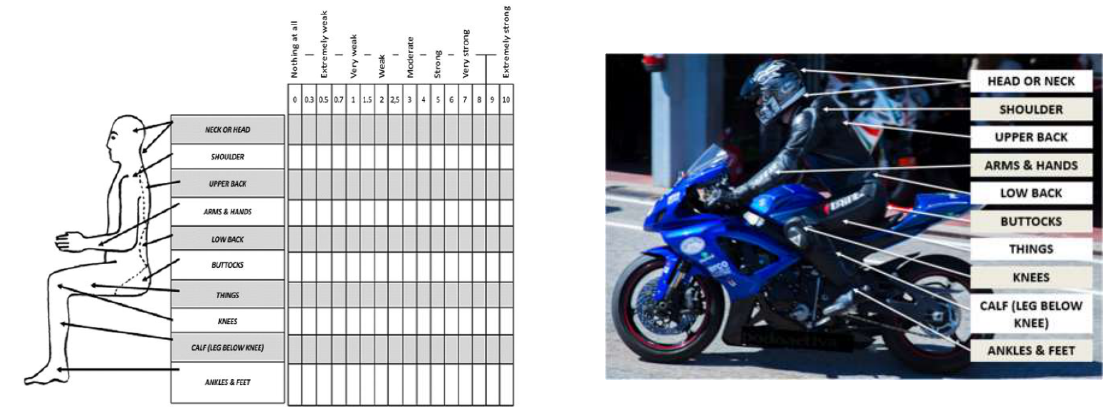
Figure 1. The left side of the body chart discomfort using the Borg CR-10 scale and the right side of the moto rider using the Borg CR-10 scale.